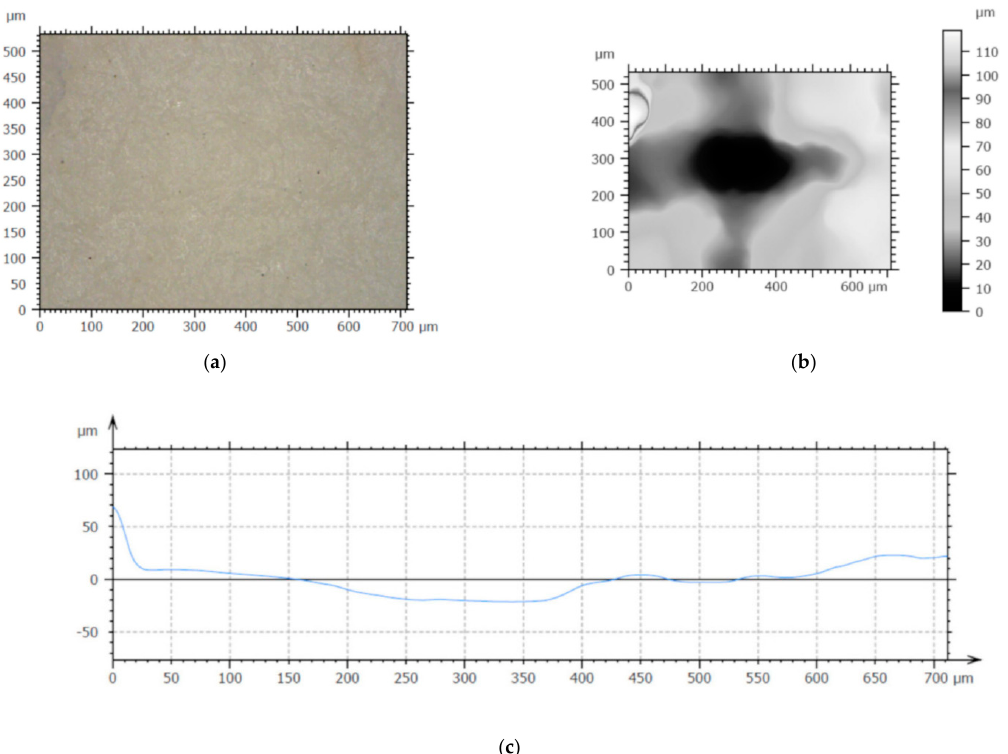
Figure 5. Tissue topography: Z—displacement, mm for animal-origin sample models; ( a ) the surface; ( b ) height map; ( c ) profile [53].